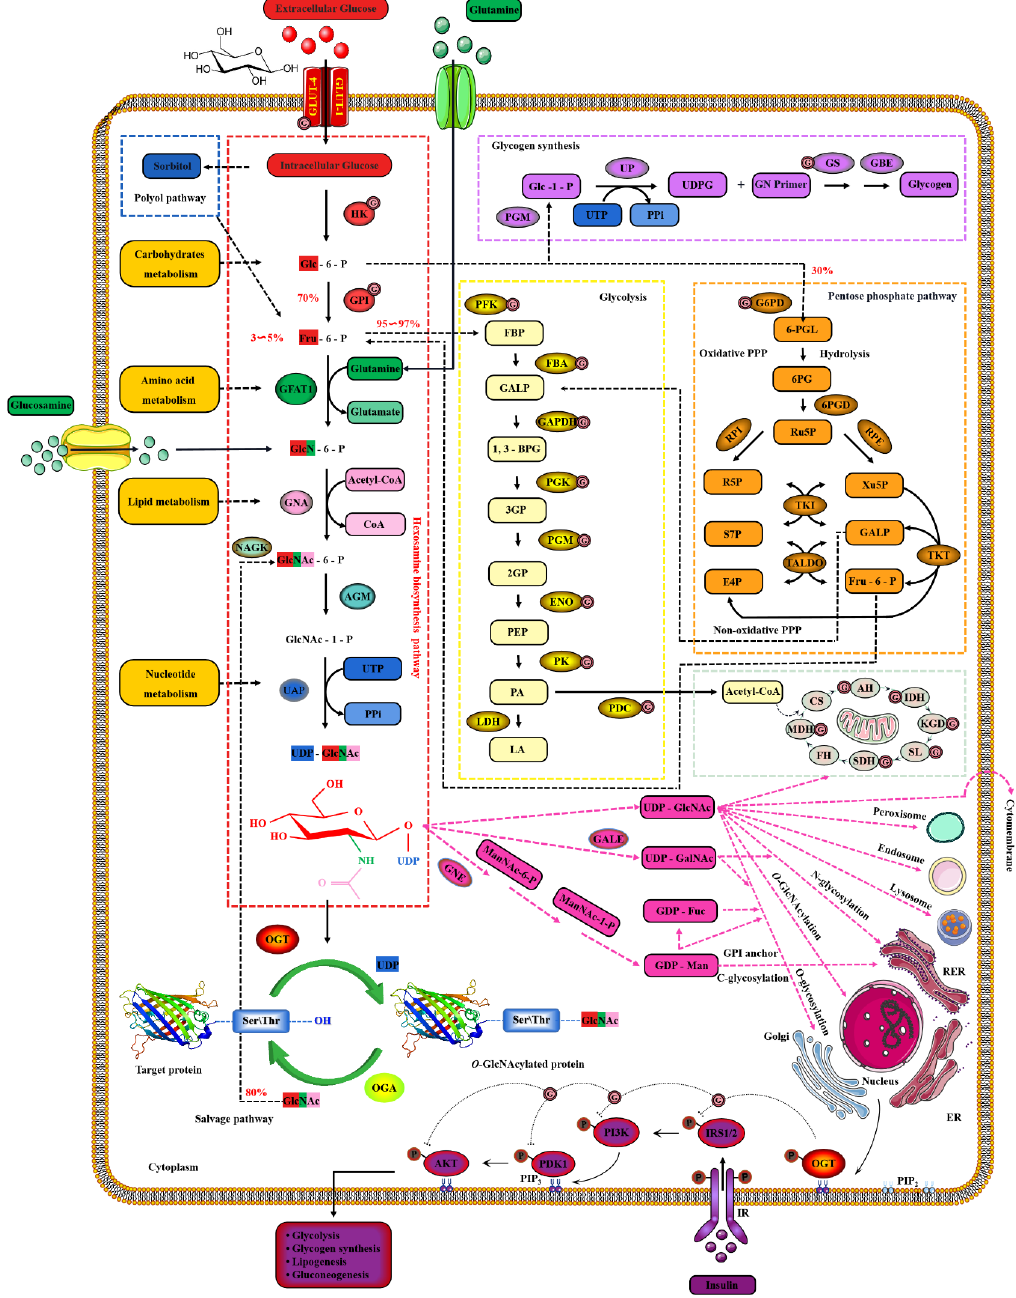
Figure 4. Nutrient availability drives the dynamic cycle of protein O -GlcNAcylation via the hex- osamine biosynthesis pathway. The GlcNAc provided by UDP-GlcNAc is necessary and unique for O -GlcNAcylation, and the only source of UDP-GlcNAc is HBP. Changes in nutritional availability, such as carbohydrates, lipids, amino acids, nucleotides and ATP, fluctuate HBP flux. Therefore, UDP-GlcNAc and HBP link carbohydrate metabolism, lipid metabolism, amino acid metabolism and nucleotide metabolism. These physiological characteristics make OGT extremely sensitive to nutrient